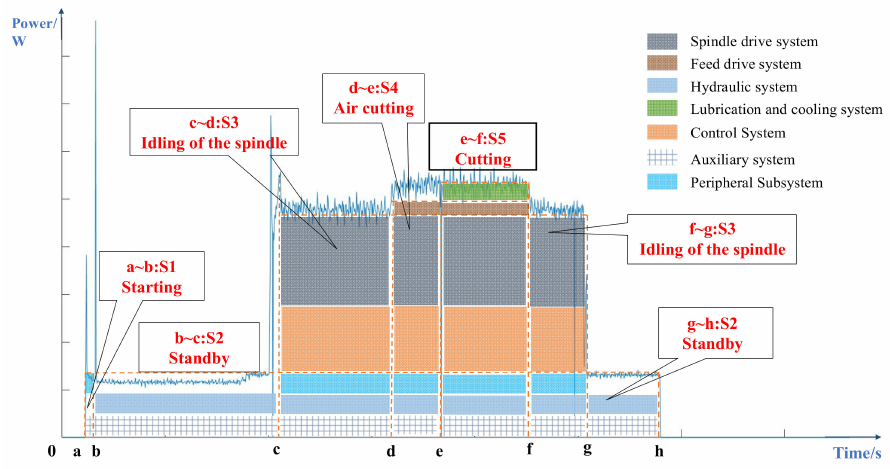
Figure 1. Power curve of the XK713 machine tool